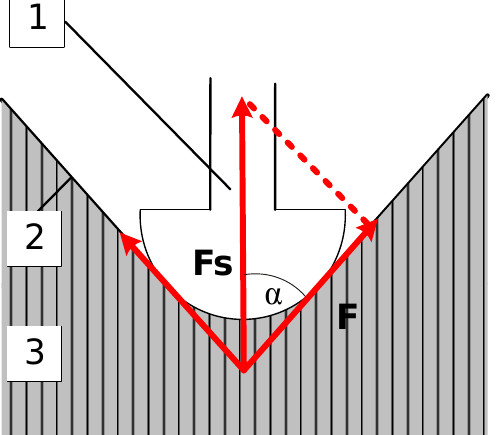
Figure 2. A simplified representation of the MC measuring principle for the determination of the mechanical and physiological properties of skeletal muscles (1): sensor tip; (2): skin and intermediate layer; (3): measured